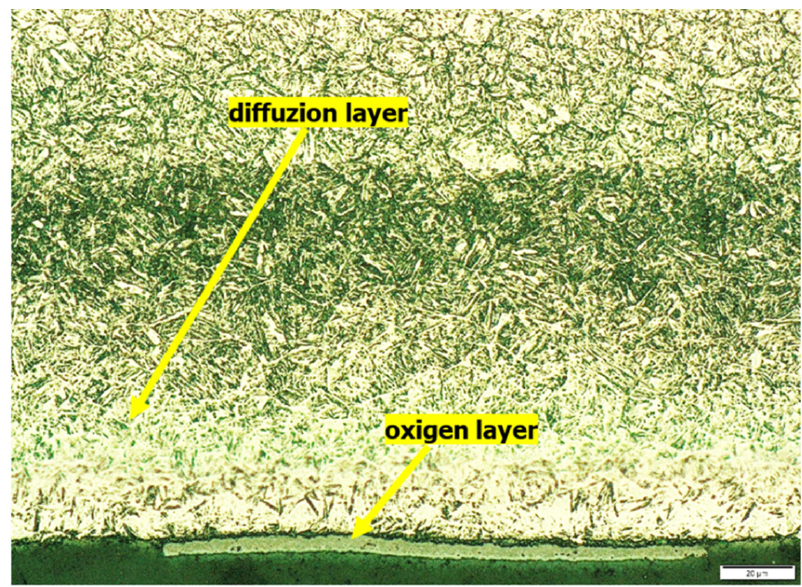
Figure 2. The structure of the v2 sample cross-section, magnification 2500 × .